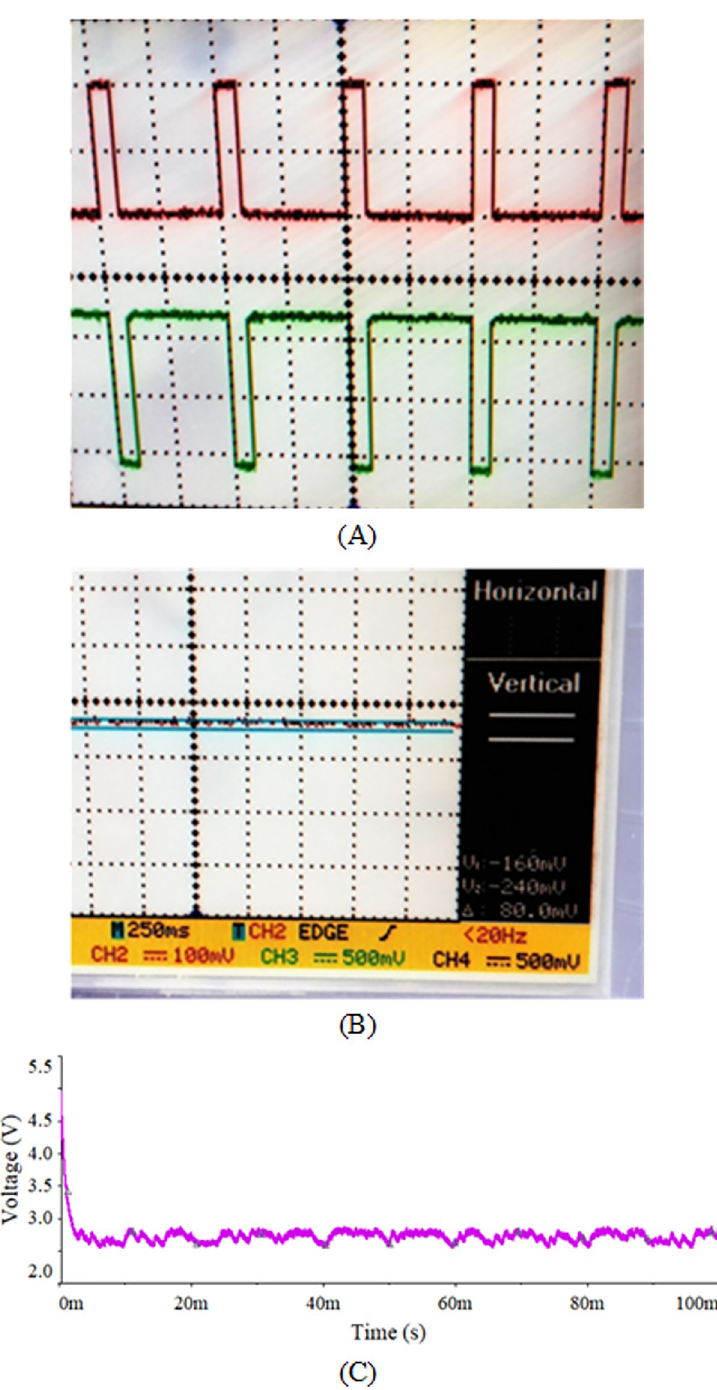
Fig 13. (A) PWM waveform of driving circuit on the oscilloscope, (B) output waveform of a dc-dc buck converter using the oscilloscope, and (C) output voltage of dc-dc buck converter through